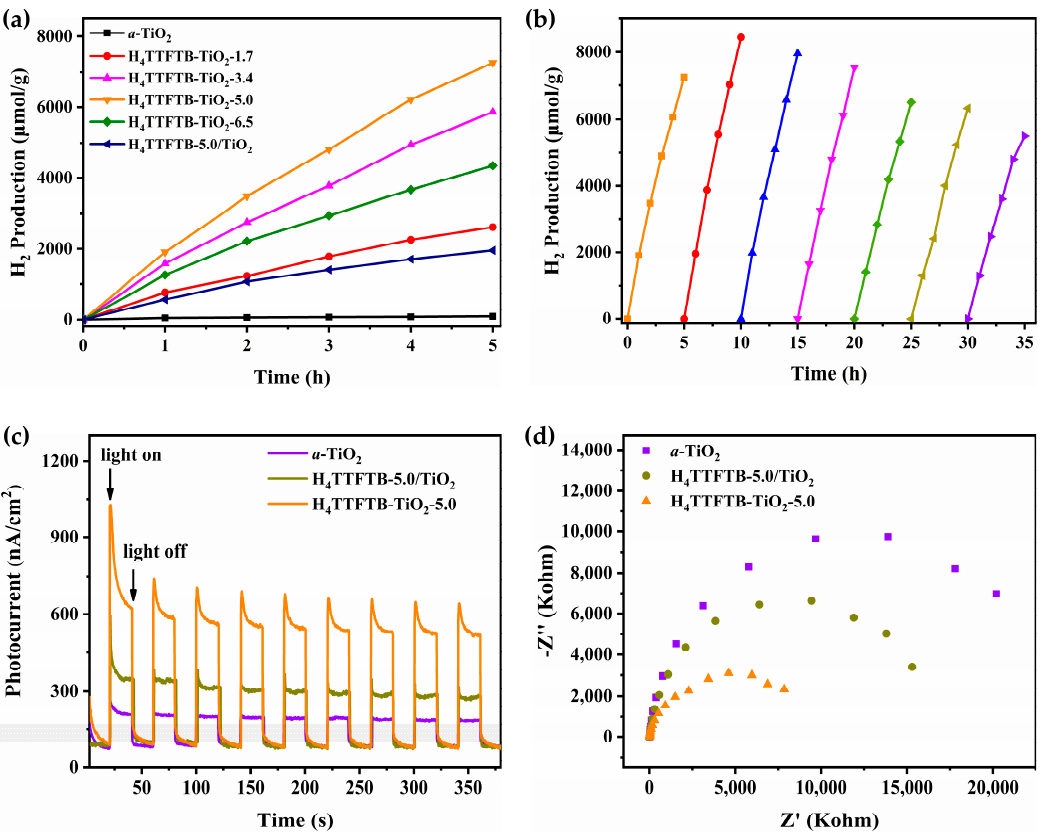
Figure 6. ( a ) Effect of the amount of H 4 TTFTB doped into the TiO 2 on the performance of photocatalytic hydrogen production, ( b ) Photocatalytic H 2 production over the recyclability of H 4 TTFTB-TiO 2 - 5.0 in 20 mL H 2 O/TEOA (9:1 v/v ) with 1.0 wt% Pt loading under visible light irradiation ( λ > 400 nm), ( c ) Transient photocurrent responses and ( d ) EIS Nyquist plots.